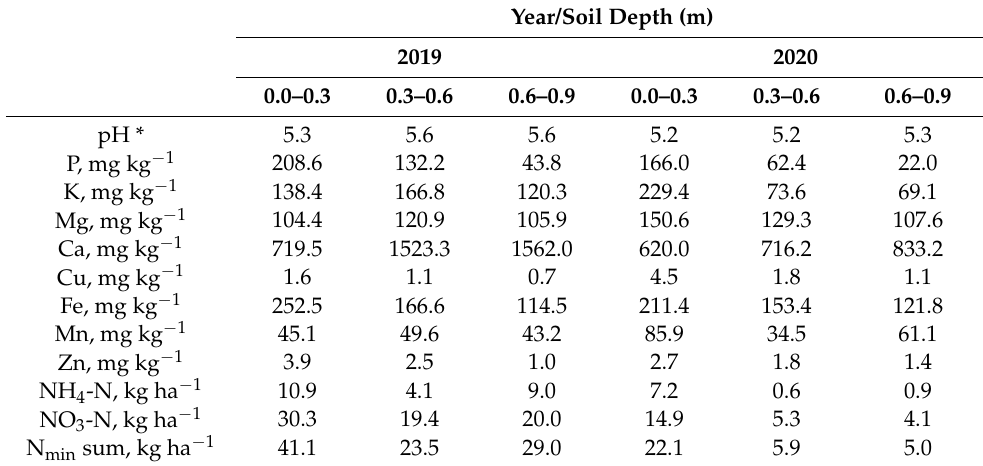
Table 6. Agrochemical properties of soil prior to